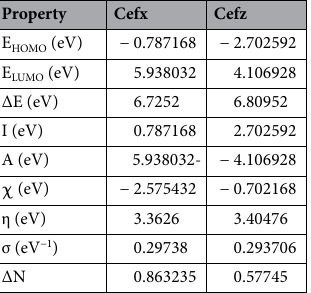
Table 8. Calculated quantum chemical parameters for Cefx and Cefz based on HF/6–311++G (d, p)